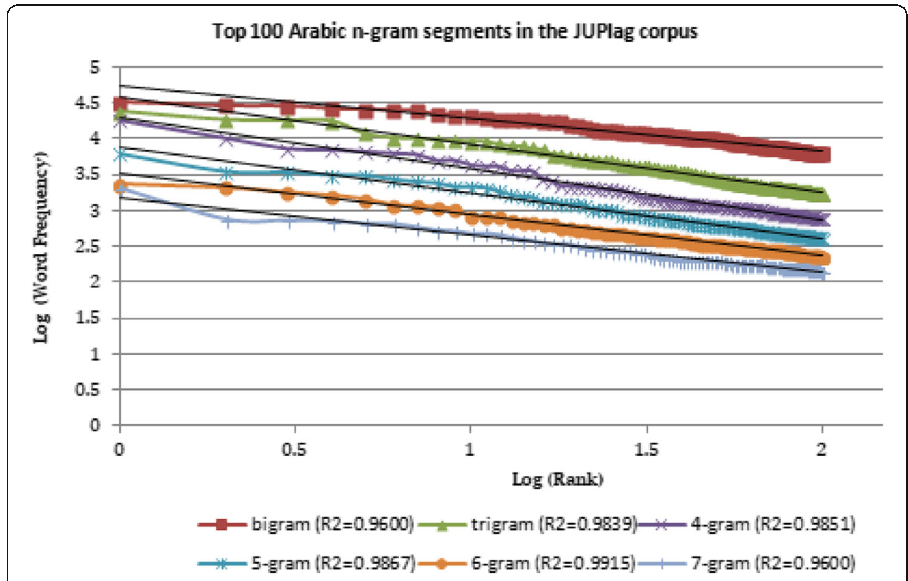
Fig. 4 Zipf ’ s distribution of the top 100 Arabic n-gram segments in JUPLag corpus